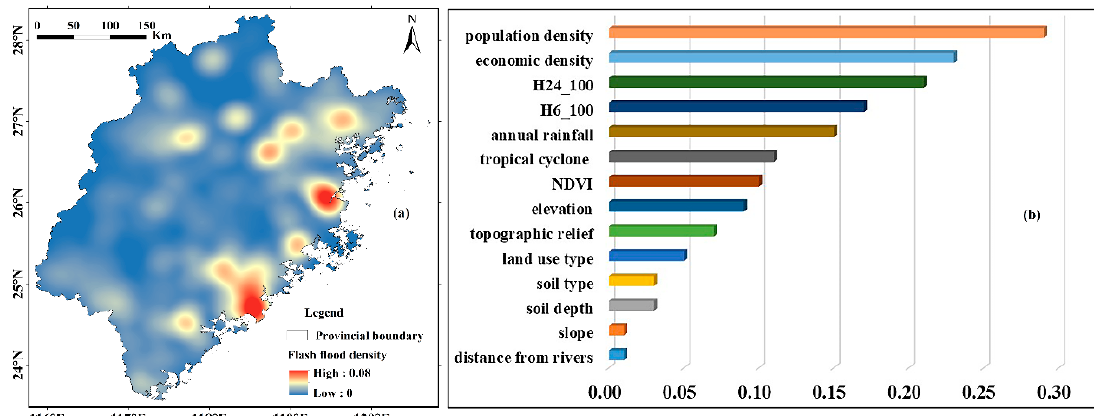
Figure 2. ( a ) Flash flood density of Fujian Province and ( b ) the q-statistic indices calculated by Geodetector.